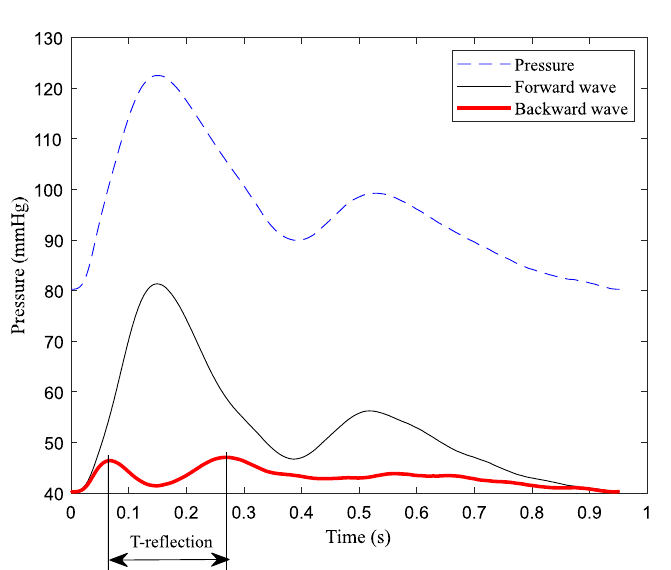
Figure 3. Decomposition of the pulse wave in the radial